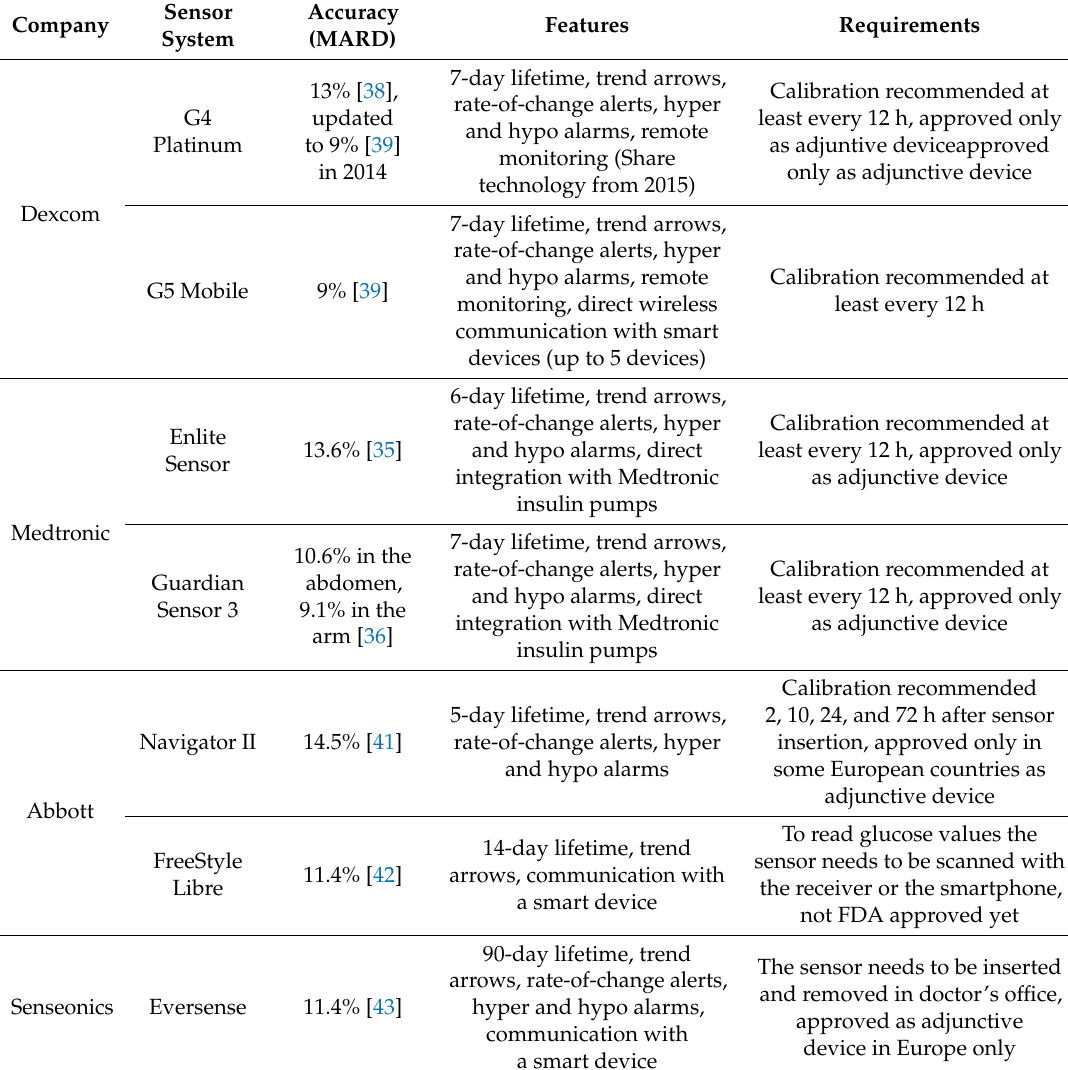
Table 1. Summary of the currently commercialized CGM sensor systems performance, features and